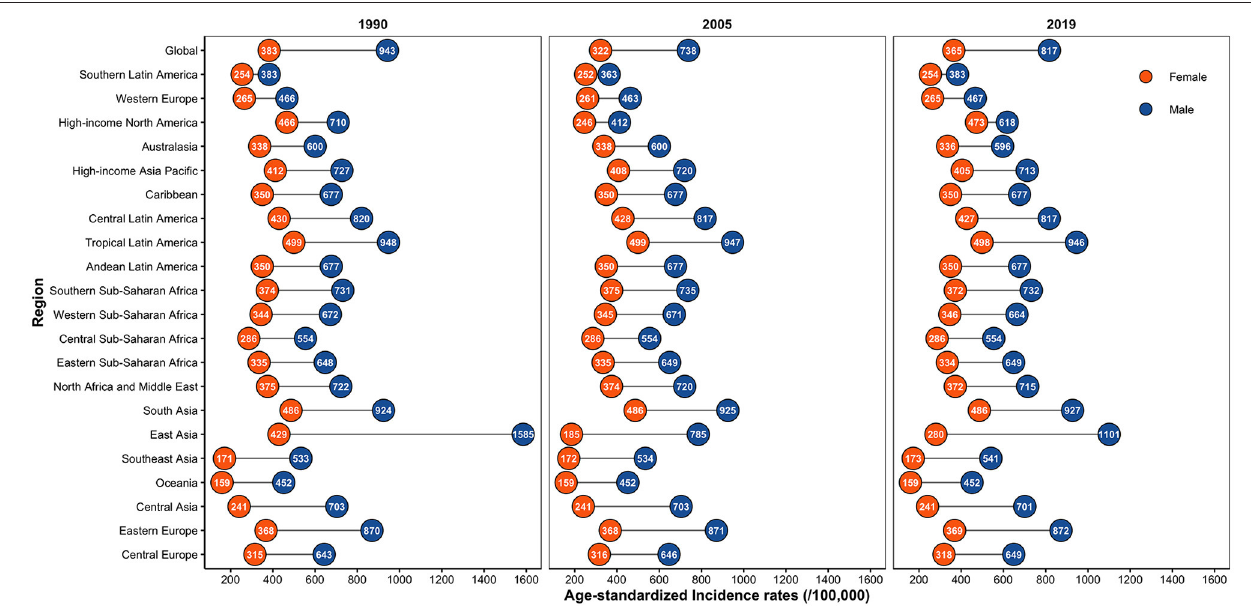
FIGURE 4 | Global sex-specific IOFBs burden by regions in terms of ASIR (per 100,000 persons) in 1990, 2005, and 2019. IOFBs, intraocular foreign bodies; ASIR, age-standardized incidence